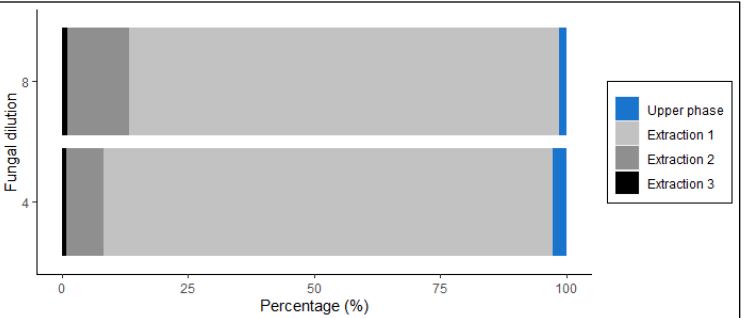
Figure 1. Percentages of ergosterol extracted with chloroform–methanol approach from two fungal dilutions (4×, and 8×) of the marine fungal isolate Rhodotorula sphaerocarpa . Extracts recovered from the upper (one extraction) and lower (three extractions) phases were analyzed.